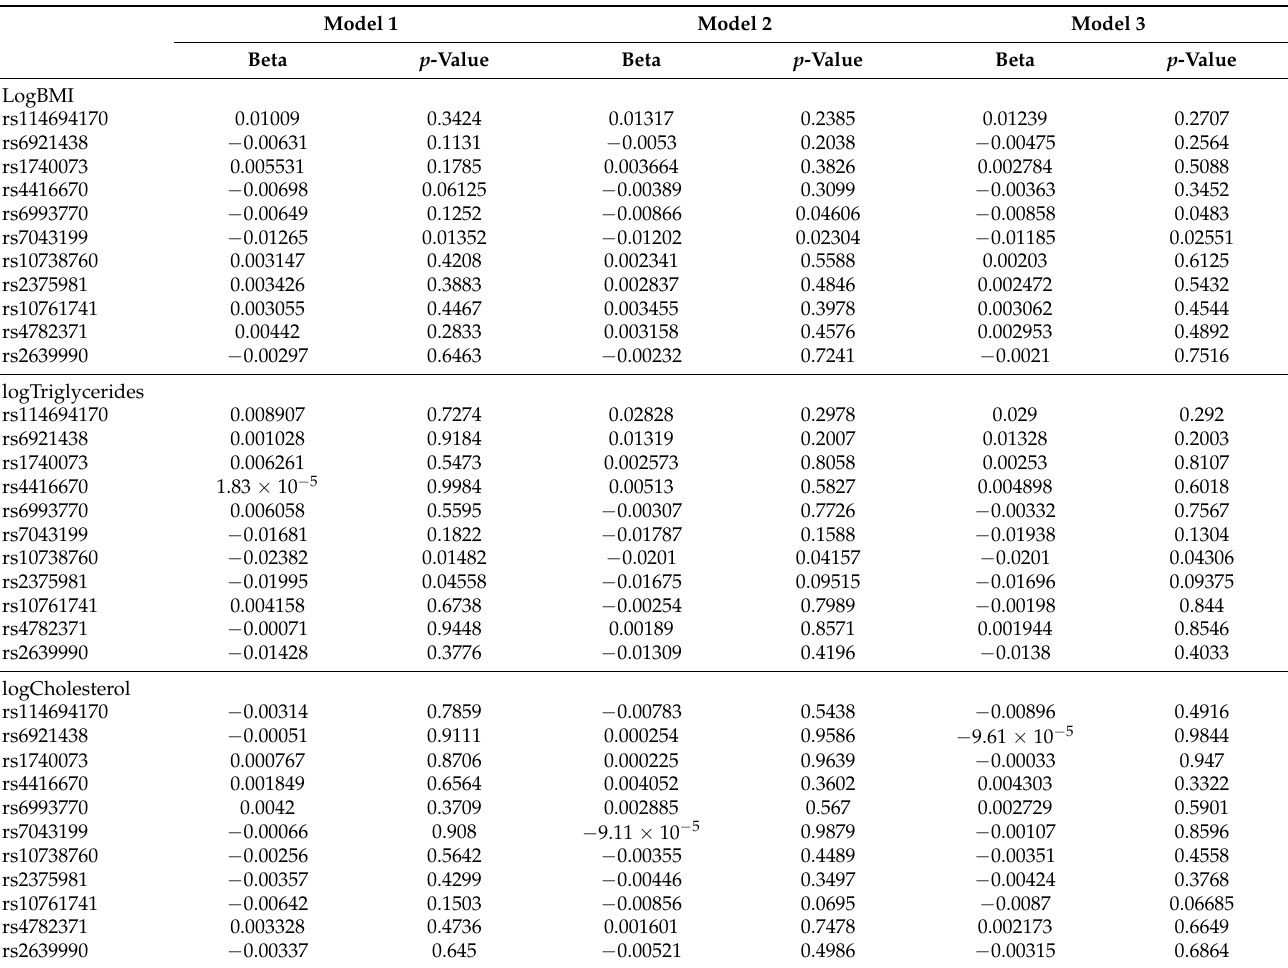
Table 3. Associations between the 11 VEGF-A-related SNPs and cardiometabolic indices in the TEENAGE